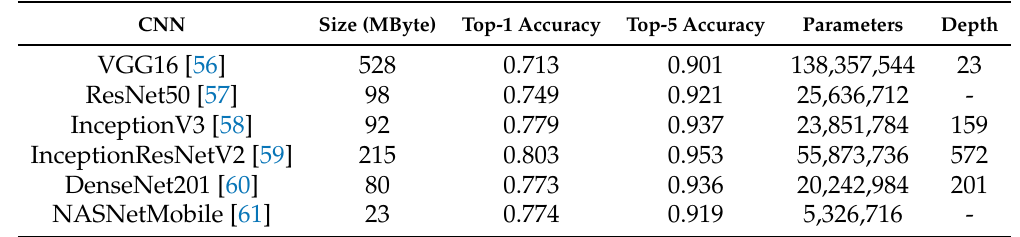
Table 2. On ImageNet [62] database pretrained CNNs applied in this study. In this table, Top-1 and Top-5 accuracy refers to the model’s performance on the ImageNet [55] validation dataset.